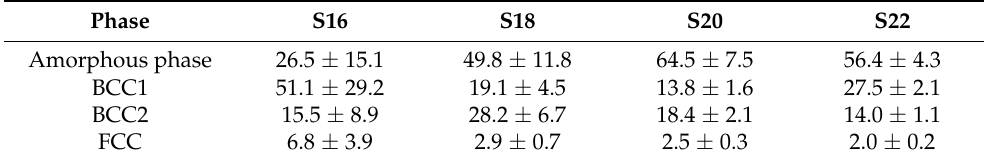
Figure 3. XRD patterns observed for the studied samples S16–S22; the background levels shifted for clarity; the crystalline phase symbols, angular positions, and Miller indices of the diffraction maxima are indicated. Table 2. Phase composition (volume %) of the studied layers obtained by XRD phase analysis with the substrate contribution subtracted.